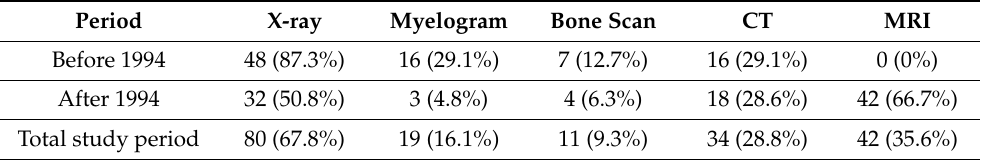
Table 1. Imaging techniques that each case underwent during the process of diagnosing the infection. The year 1994 represents the first report of MRI being used for diagnosis. CT: computer tomography, MRI: magnetic resonance imaging.